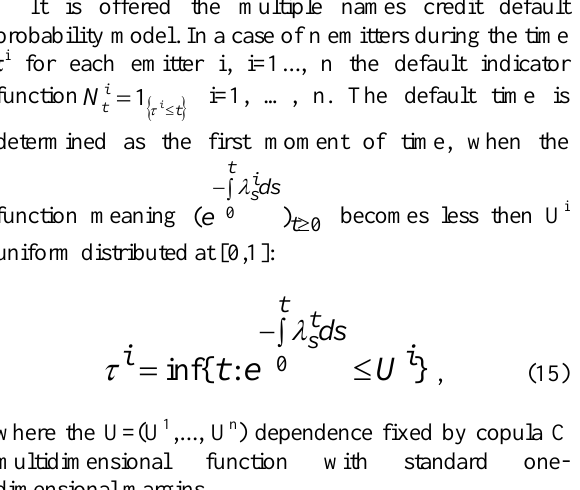
Table 1. Various distributions tranches DJ iTraxx